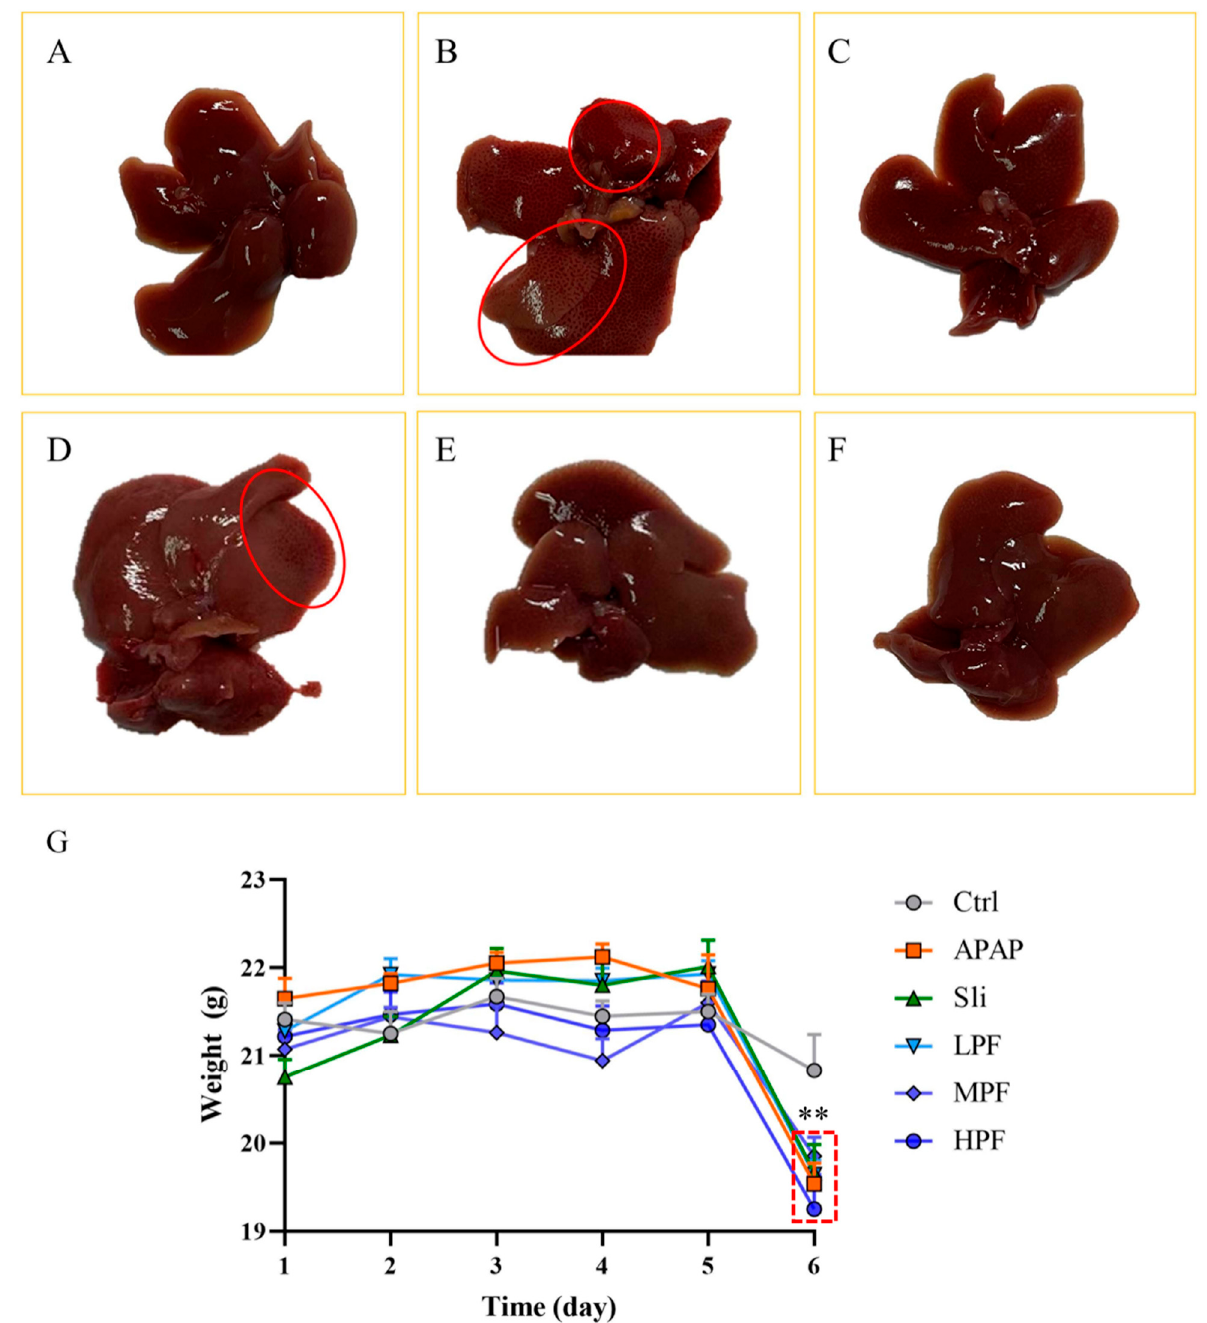
Figure 2. Effects of PF on macroscopic pathological changes of DILI mice. ( A ) The control group (Ctrl); ( B ) the APAP group (APAP); ( C ) the silibinin group (Sli); ( D ) the paeoniflorin low dose group (LPF); ( E ) The paeoniflorin middle dose group (MPF); ( F ) the paeoniflorin high dose group (HPF); ( G ) weight of mice during the experiment. The red circles indicate the lesions of the liver. ** p < 0.01, compared with Control group.